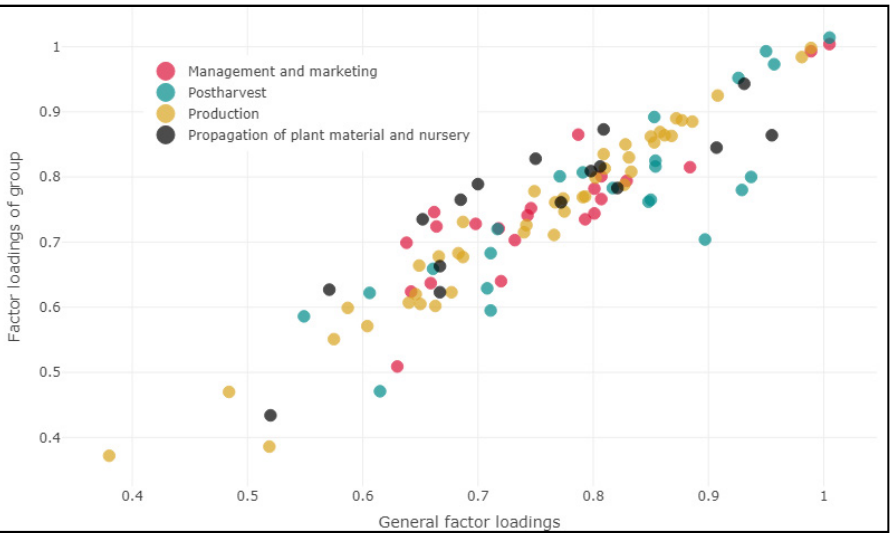
Figure 1. Factorial load to technologies evaluated and by group of technologies according to the stage of the value chain. Source: Authors.